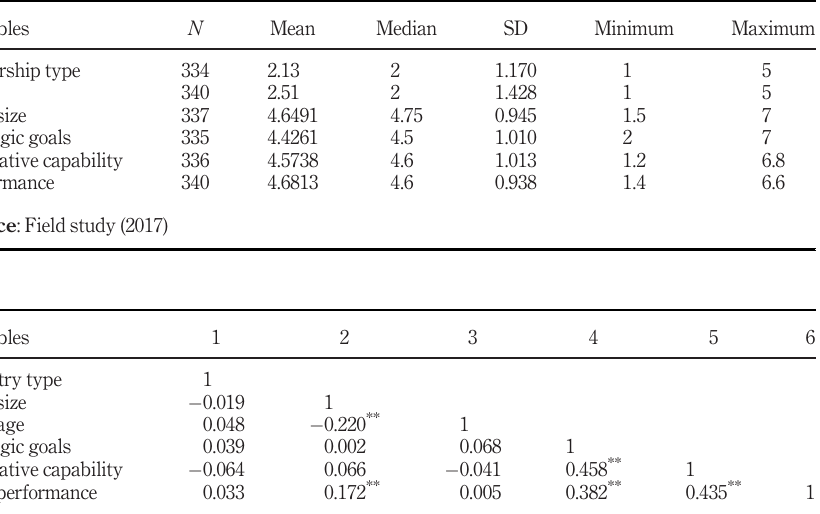
Table IV. Correlation analysis